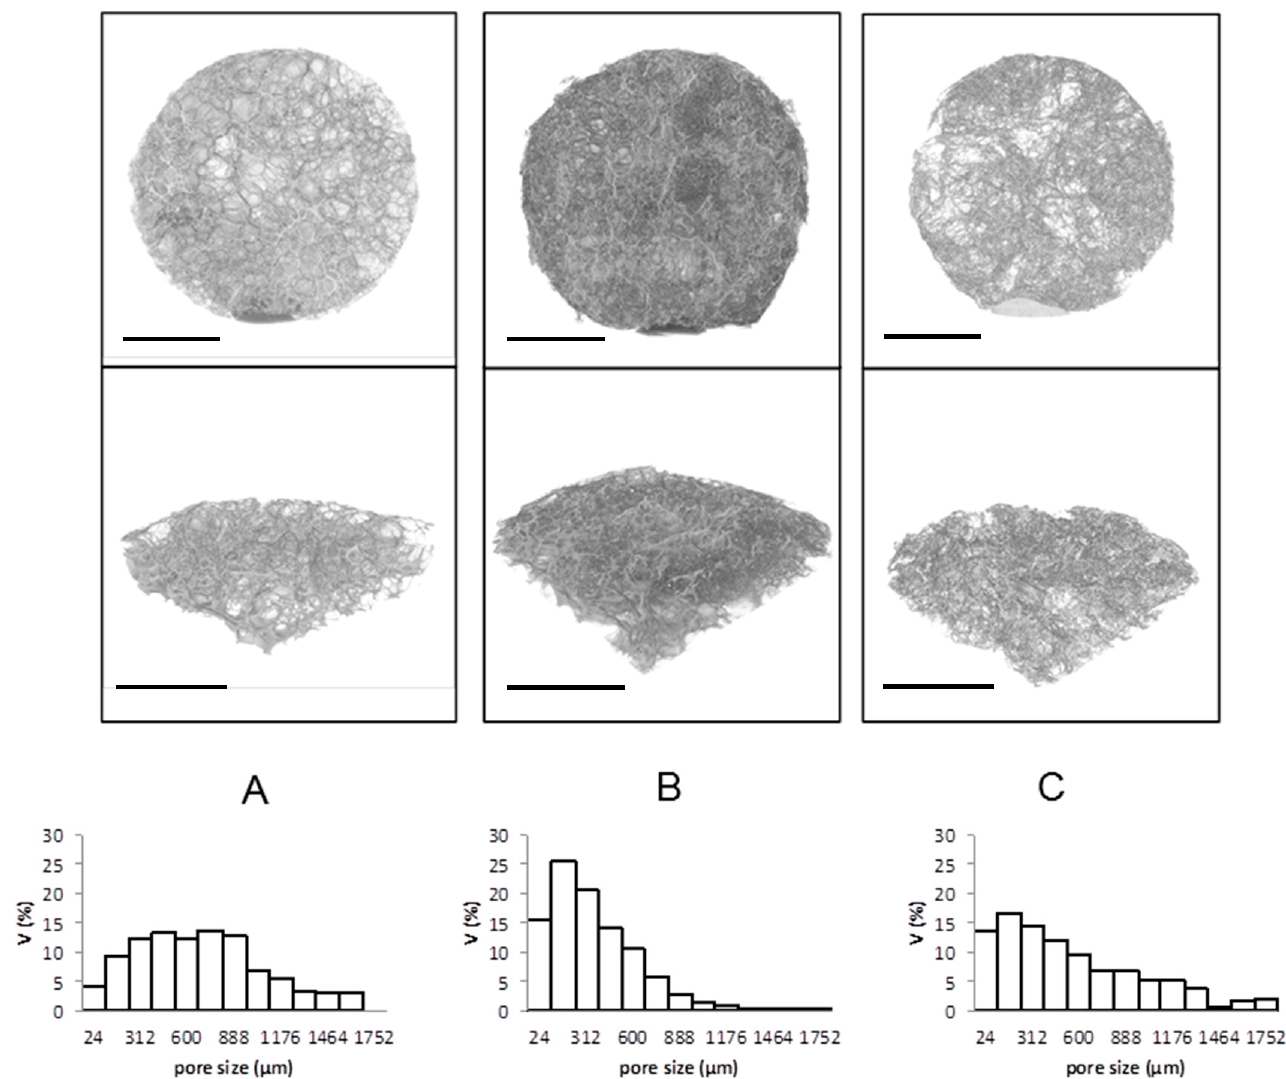
Figure 3. SEM images corresponding to longitudinal ( A – C ) and cross-sections ( D – F ) of ( A , D ) PLA processed with Freon R134a; ( B , E ) PLA processed with scCO 2 ; and ( C , F ) PLGA processed with Freon R134a.